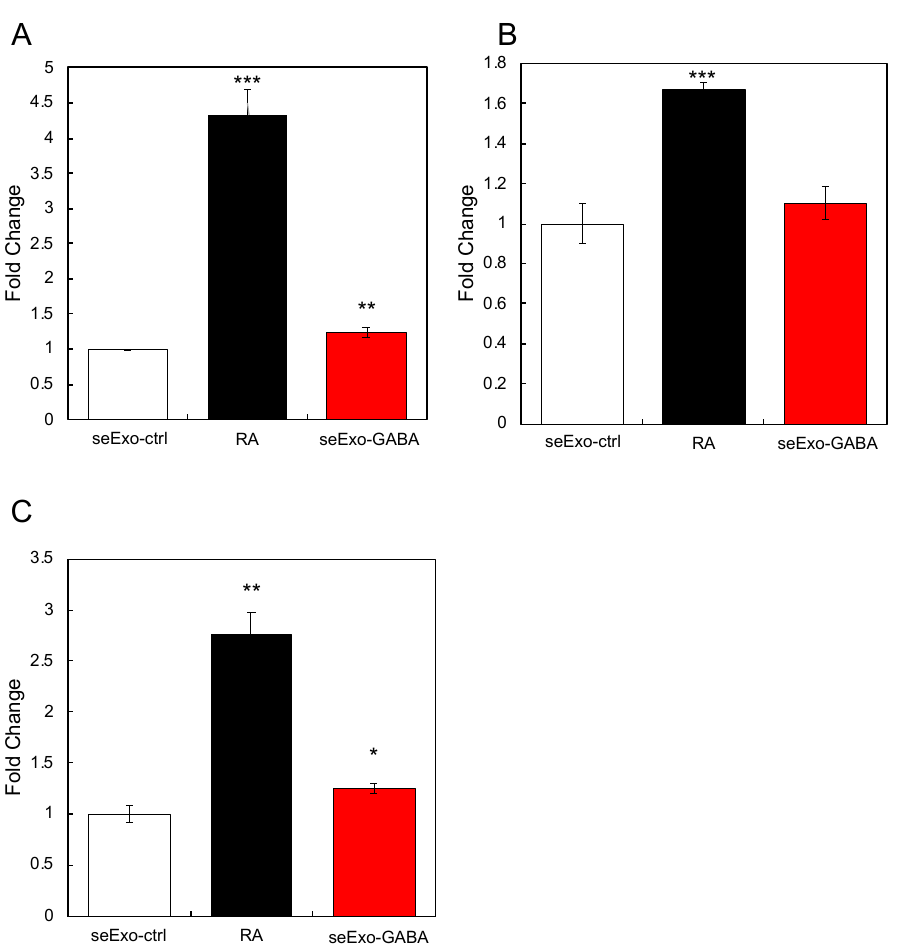
Figure 5. Effects of exosomes derived from serum of GABA-treated mice (seExo-GABA) on gene expression. Exosomes derived from serum of non-treated mice (seExo-ctrl) was used as control. Expression of BDNF ( A ), Nestin ( B ), and NEFM ( C ) in SH-SY5Y cells treated with seExo-GABA was evaluated by RT-qPCR. RA was used as positive control. Multiple comparisons between groups were carried out by one-way ANOVA with Tukey’s post-hoc test. Statistical difference was evaluated by comparing to seExo-ctrl. Statistical significance was defined as p < 0.05 (* p < 0.05; ** p < 0.01; *** p < 0.001) (value means ± SEM, n = 3).